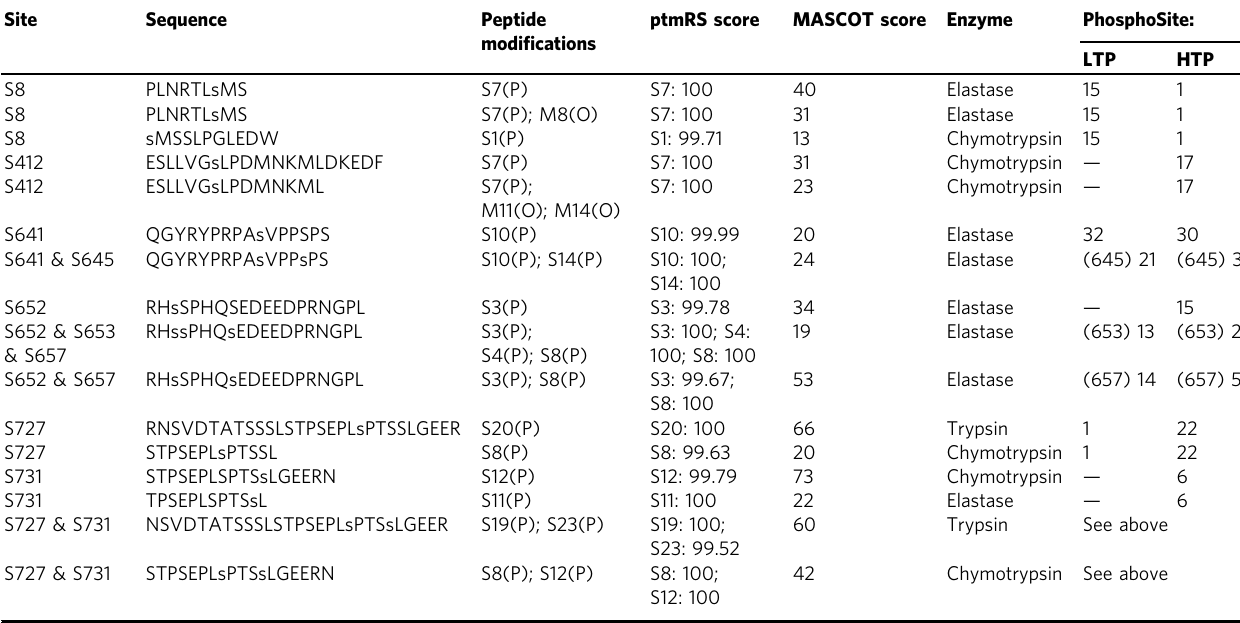
Table 1 Summary of GS phosphorylation site